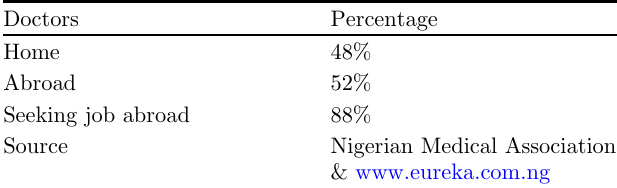
Table 6. Statistics on Nigerian